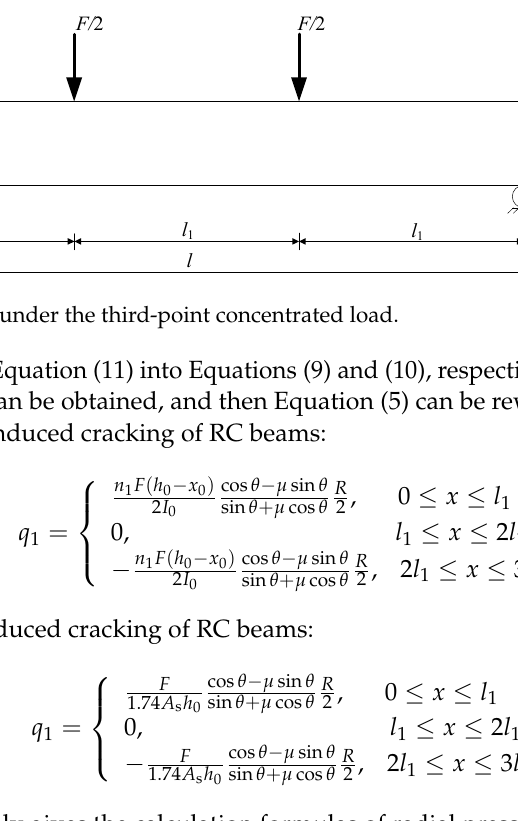
where M ( x ) is the bending moment at the distance x from the left support of beams under the third-point concentrated load, and l 1 is 1/3 of the calculated span of RC beams.